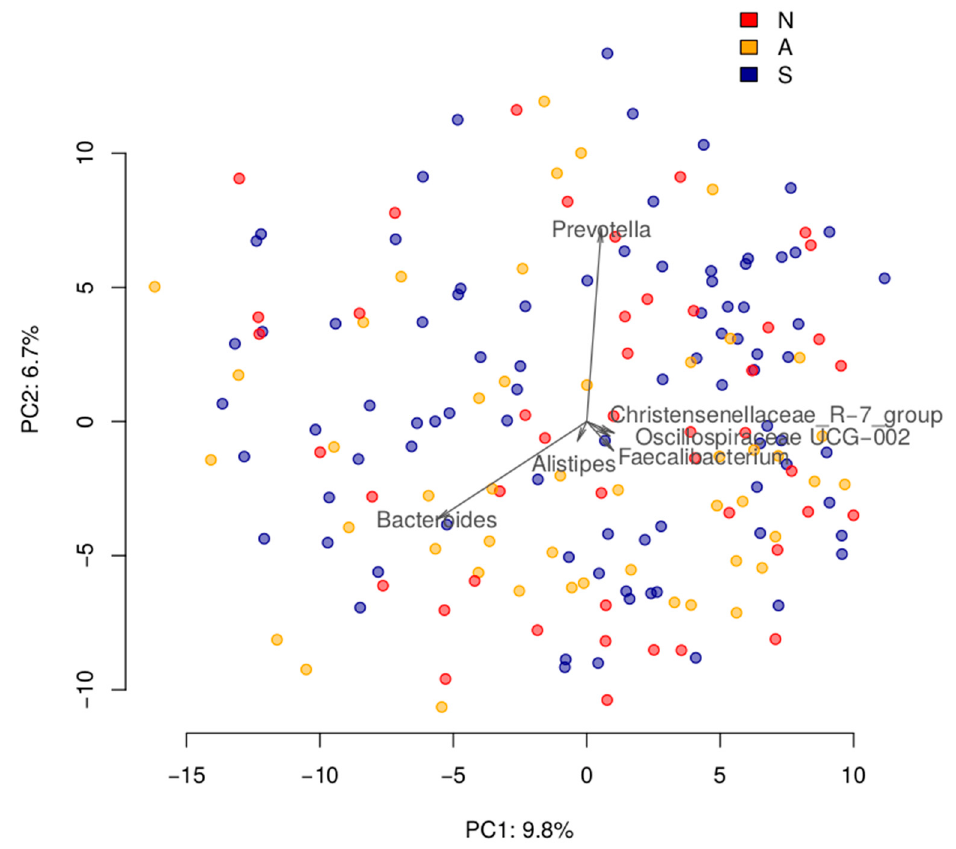
Figure 1. Overall comparison of post-COVID gut microbiomes across the three groups of patients with different courses of infection. The samples are visualized using Principal Coordinates Analysis (PCoA) based on the Aitchison distance. Arrows show the top taxa in terms of the explained variance in given axes, with the length proportional to the variance explained by the taxon. The arrows’ angle reflects the distribution of variance between the axes. N—non-infected group, A—asymptomatic group, S—severe